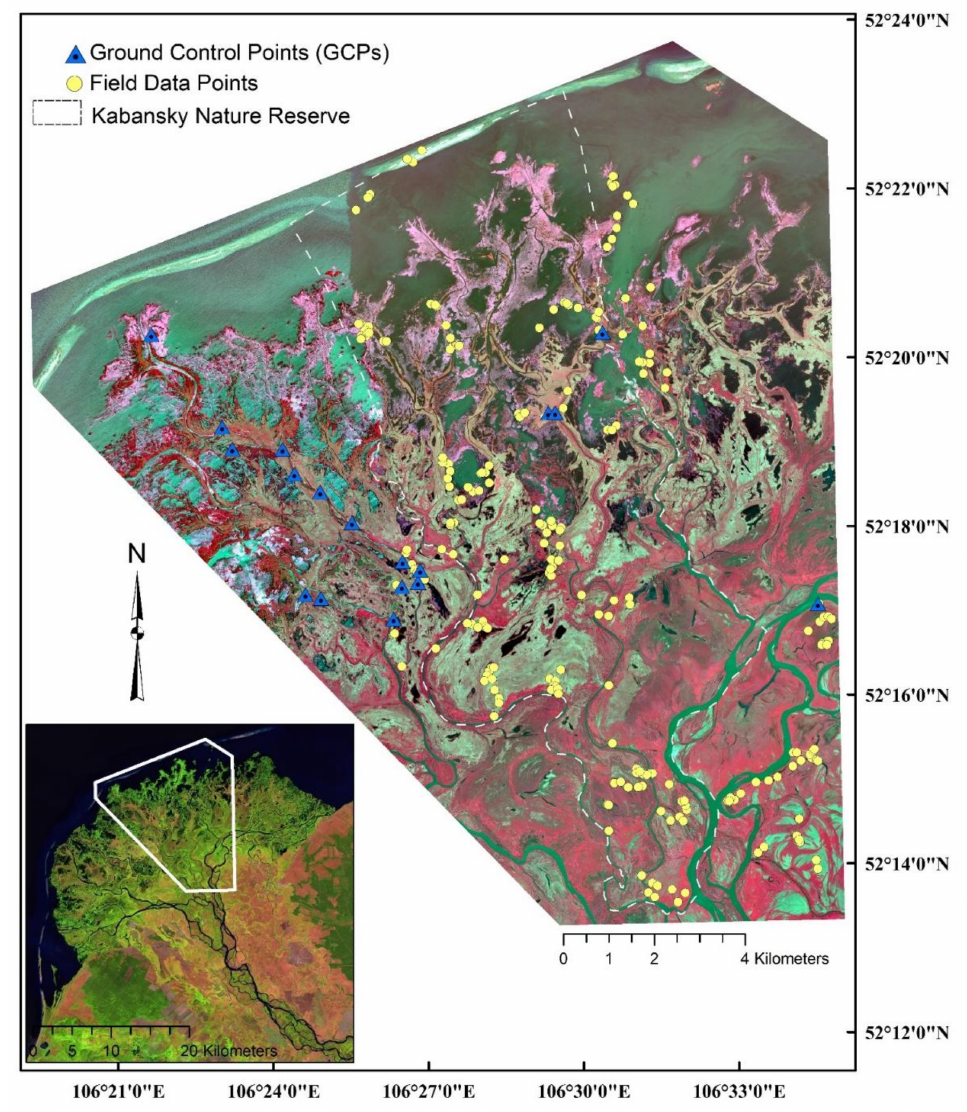
Figure 2. WorldView-2 false-color composite (near infrared-1 (NIR1), red, green) of the study area showing the spatial location of the field-sampling locations and ground control points. Inset image shows the Selenga River Delta in Lake Baikal and the study area